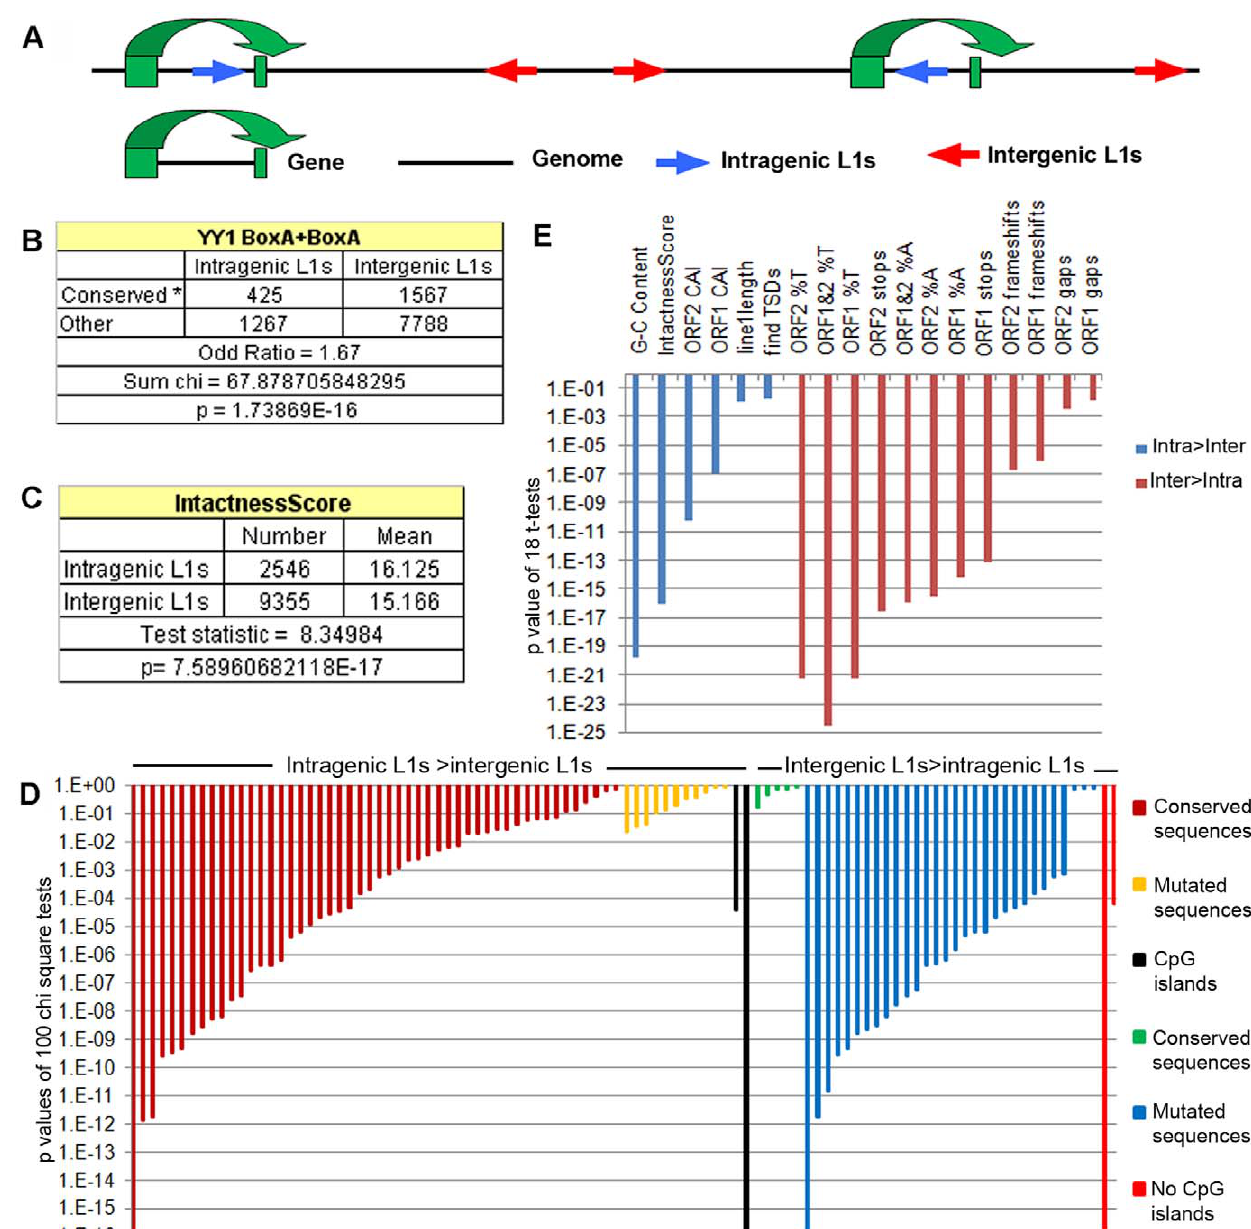
Figure 1. Intragenic L1s are conserved. A) L1s were divided into two classes, intragenic and intergenic L1s which are represented by blue and red arrows, respectively. B) The differences in structural characteristics between L1 groups were analyzed using the chi-square test, for categorical features and C) homoscedastic t -test for non-categorical features. D) 100 p-values of chi-square tests of three classes of L1 sequence characters, the conserved sequences, the mutated sequences and the presence of CpG islands, that are found overrepresented or underrepresented in intragenic L1s were displayed, intragenic L1s . intergenic L1s and intergenic L1s . intragenic L1s, respectively. E) 18 p-values of t-tests of L1 characters that are overrepresented and underrepresented in intragenic L1s were shown in blue, intra . inter, and red color, inter . intra,